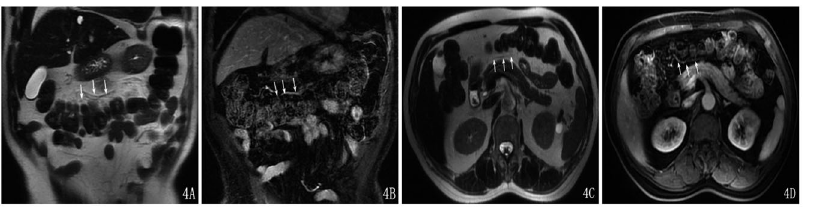
Figure 4. The transverse-mesocolon vessels were shown on the coronal SSFSE T2-weighted image (A), enhancement on the coronal image (B), on the axial SSFSE T2-weighted image (C) and enhancement on the axial image (D).